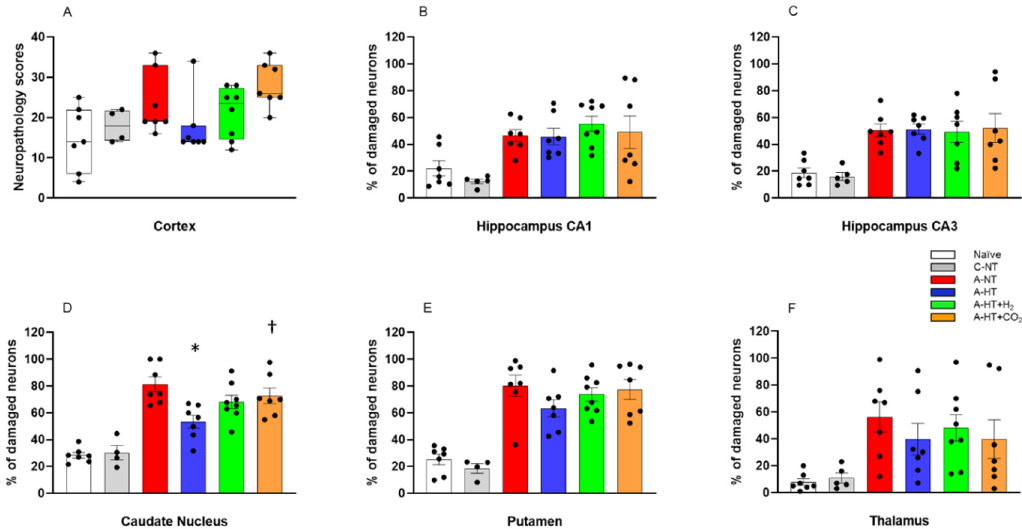
Figure 7. Neuronal injury evaluated at 48 h after asphyxia in the di ff erent cortical and subcortical regions. ( A ): In the neocortex, neuropathology scores suggested that asphyxia-induced neuronal injury was mitigated by hypothermia; however, there were no statistically significant di ff erences among the groups (lines, boxes, whiskers, and bullets represent the median, the interquartile range, the 10th-90th percentiles, and raw data, respectively). ( B – F ): In the other assessed regions, cell counting revealed no significant di ff erences in the low percentage of damaged neurons between the naïve and control-normothermia (C-NT) groups. Compared to the C-NT group, severe neuronal damage was detected in virtually all areas in the groups that were subjected to asphyxia. Neuronal damage was similar in both the CA1 and the CA3 hippocampal subfields in all groups exposed to asphyxia, despite hypothermia treatment. However, in the asphyxia-hypothermia (A-HT) group, a significant decrease in percentage of damaged neurons in the caudate nucleus was observed compared to the asphyxia-normothermia (A-NT) group, and there was a similar tendency in the putamen and the thalamus. Importantly, co-treatment with H 2 or CO 2 to achieve graded restoration of normocapnia did not augment the hypothermia-induced neuroprotection (A-HT + H 2 and A-HT + CO 2 groups, respectively). Instead, a significant increase in neuronal damage was observed in the caudate nucleus in the A-HT + CO 2 -treated group compared to the A-HT group. Data are mean ± SEM; bullets represent raw data, * vs. A-NT; † vs. A-HT, p < 0.05; statistical significance from naïve or C-NT groups is not shown. Representative photomicrographs are shown in Supplementary Figures S1–S5.